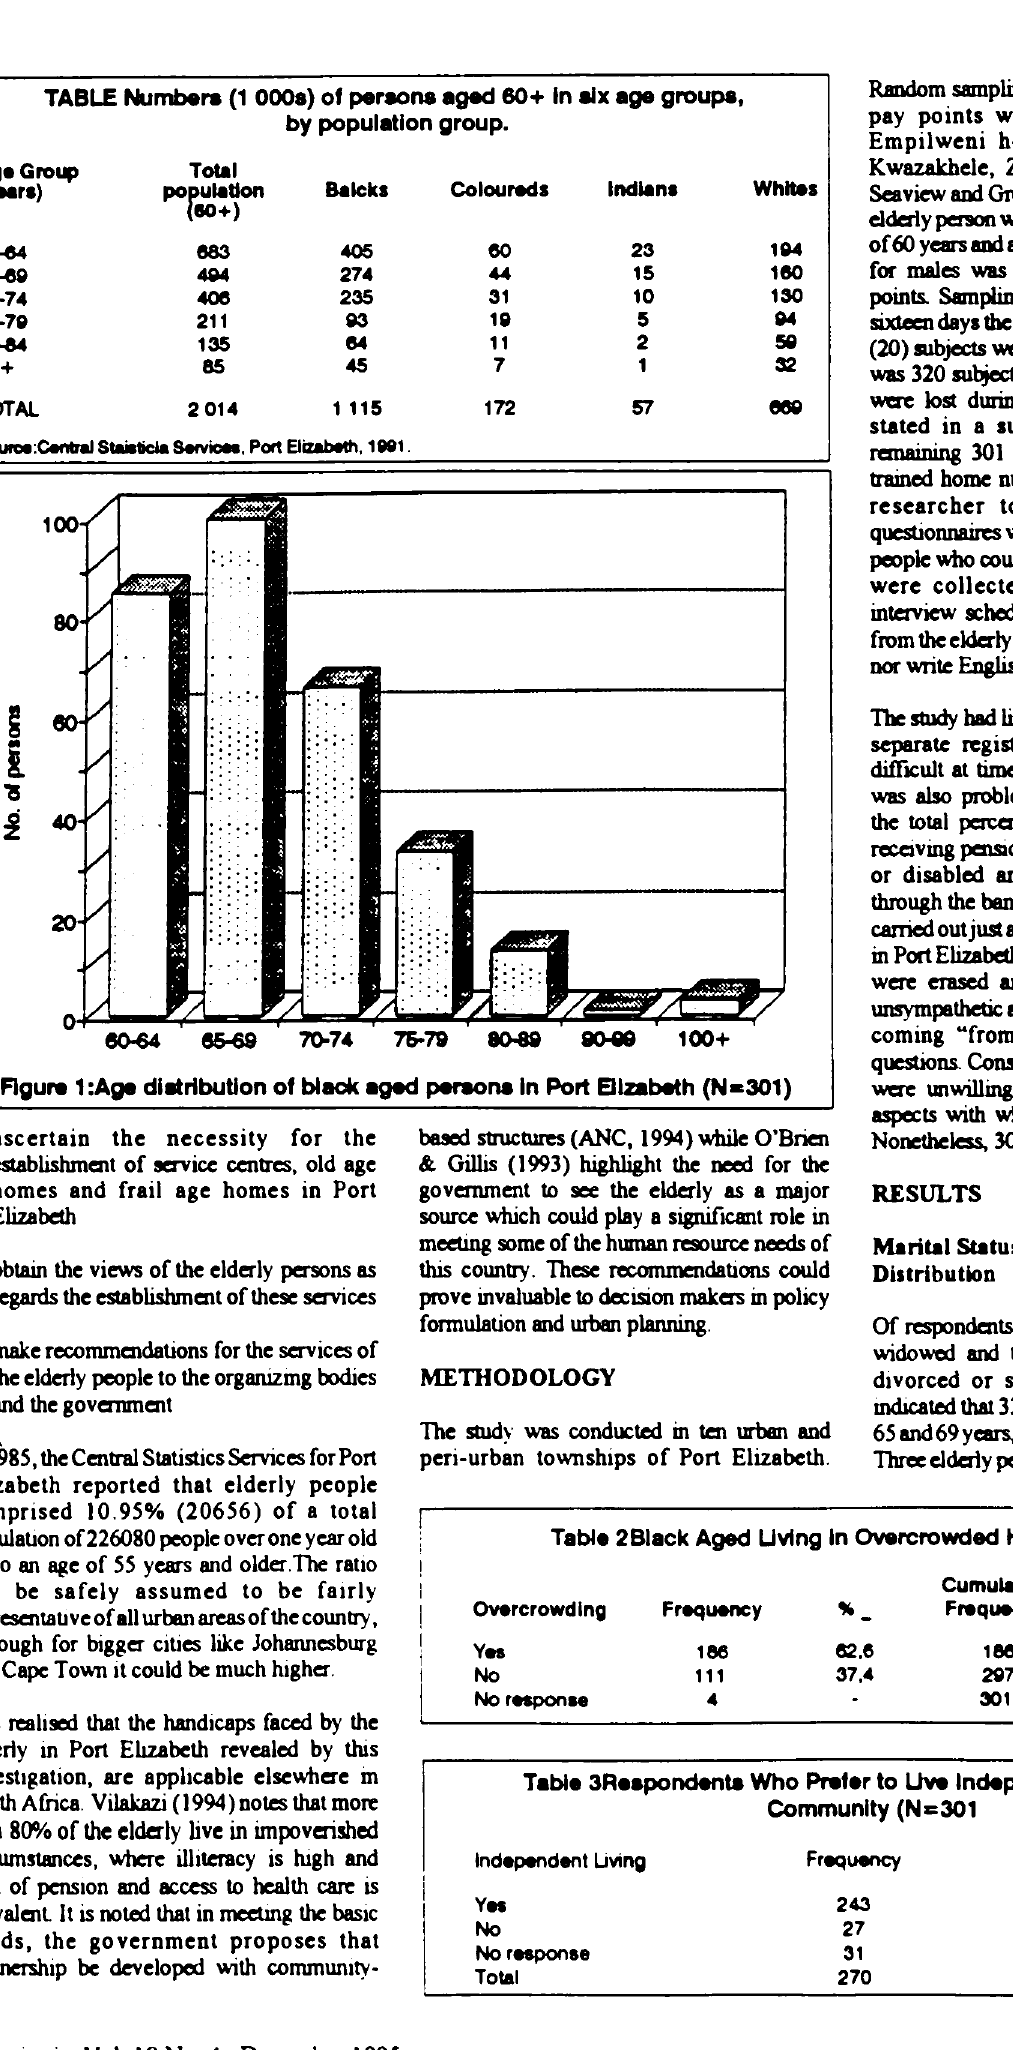
Table SRespondents Who Prefer to Live independently Within